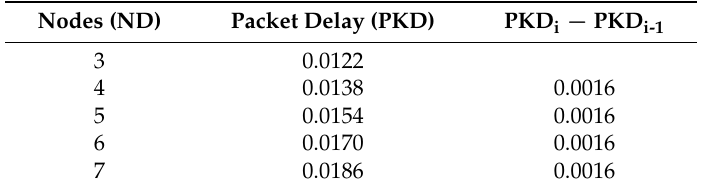
Table 4. Packet Delay Analysis.